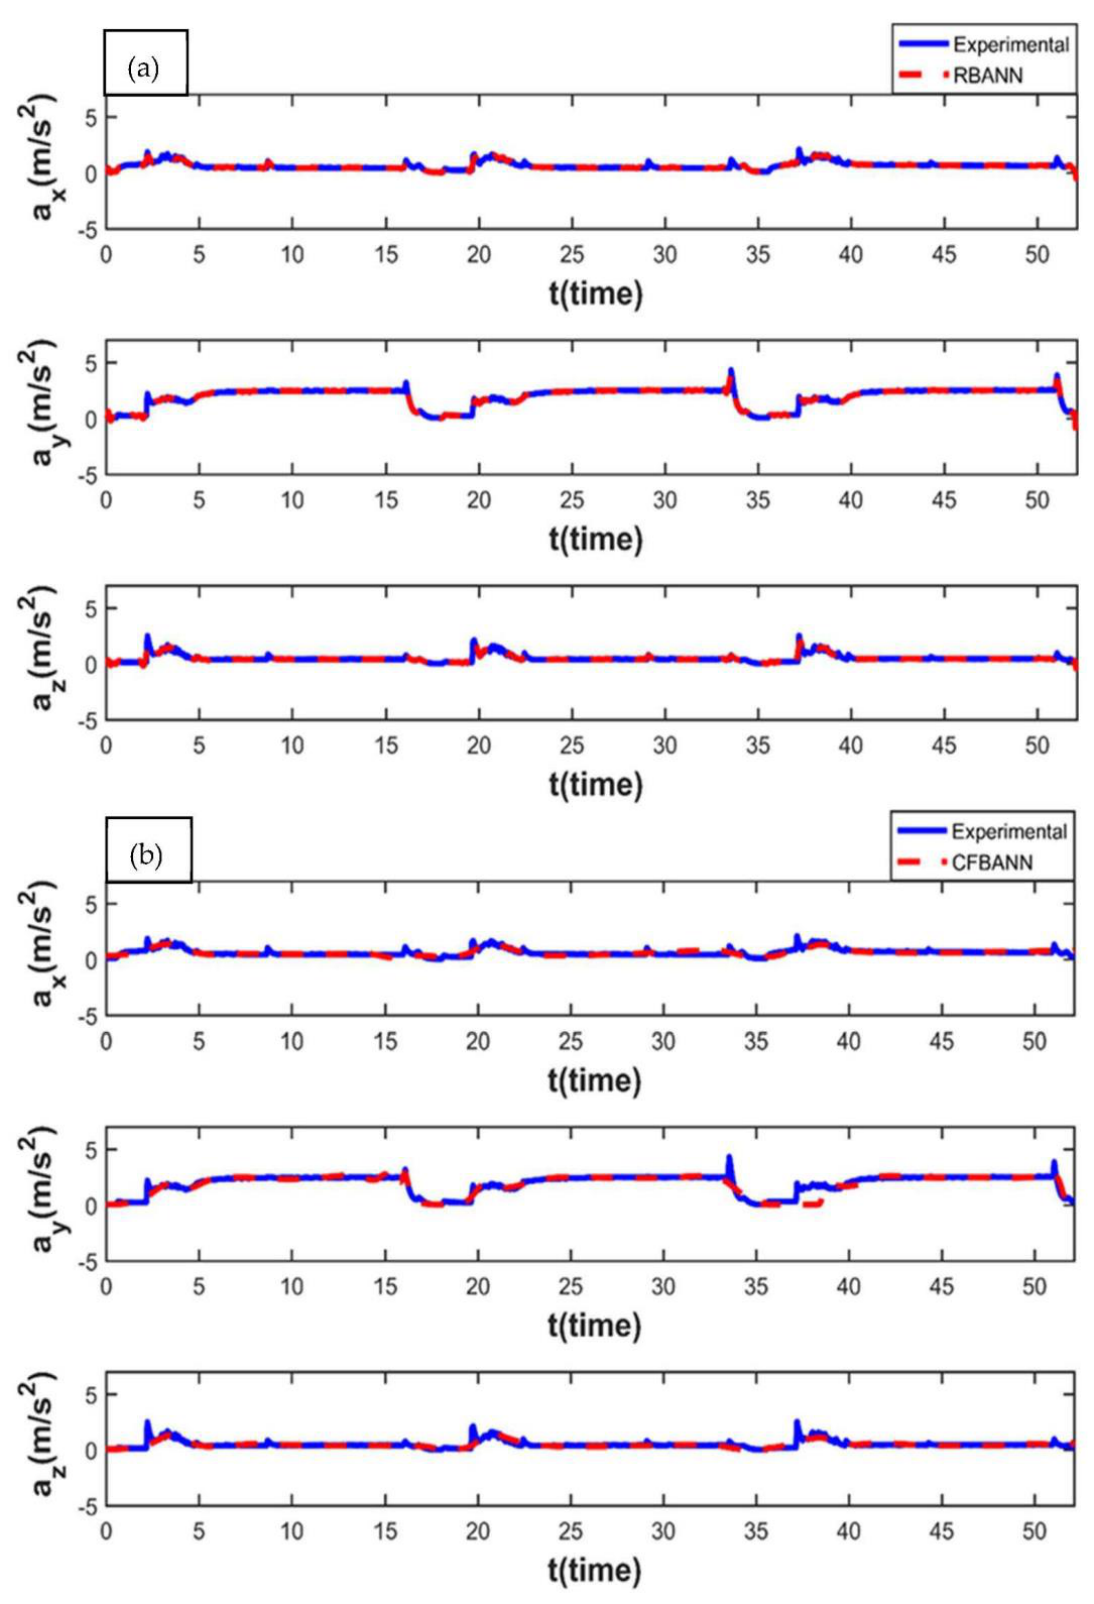
Figure 11. Experimental and ANN results obtained for the working condition of 14 s and 6.25 bar: ( a ) RBANN; ( b ) CFBANN.